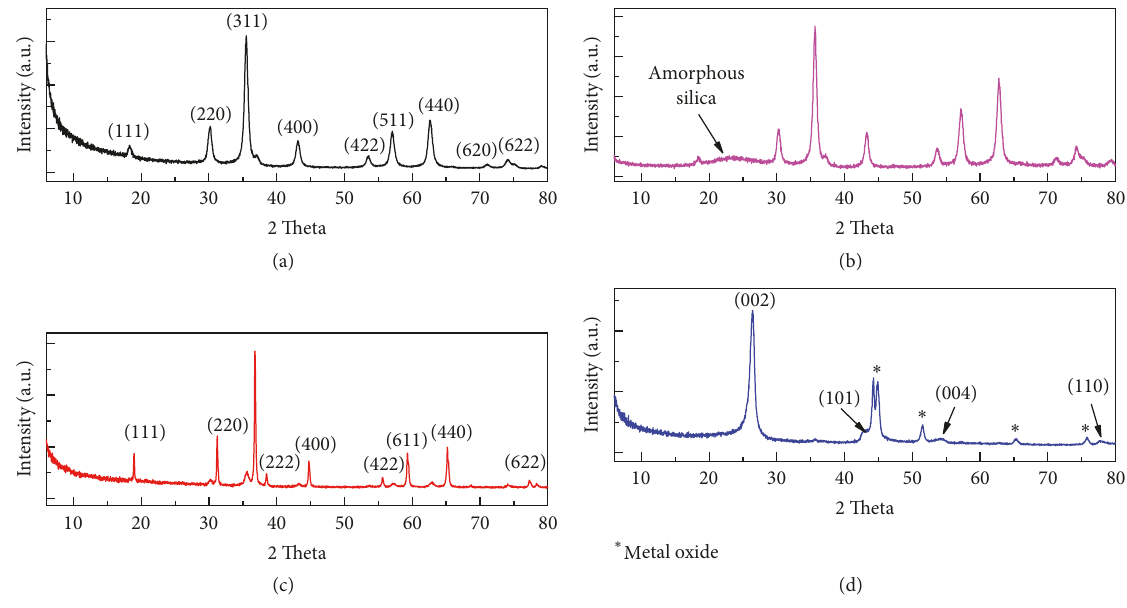
Figure 2: XRD pattern of Fe 3 O 4 (a), Fe 3 O 4 @SiO 2 (b), Fe 3 O 4 @SiO 2 -Co (c), and Fe 3 O 4 @SiO 2 -MWCNT